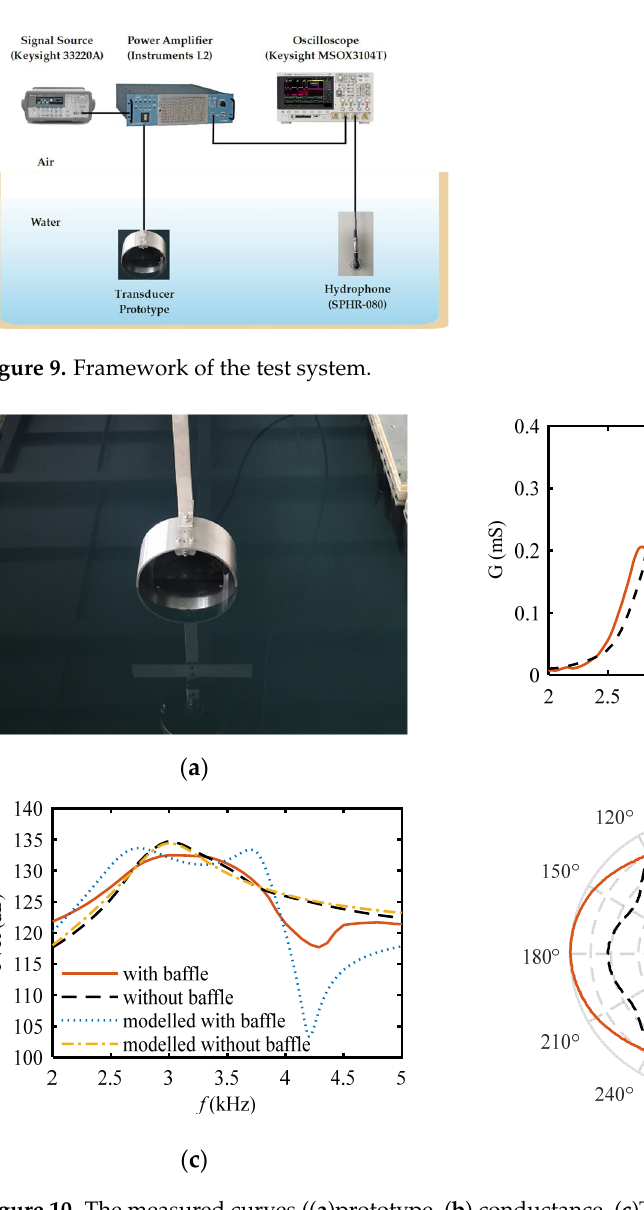
Figure 10. The measured curves (( a )prototype, ( b ) conductance, ( c )TVR, ( d ) directivity diagram). Table 2. Acoustic parameters of the transducer.